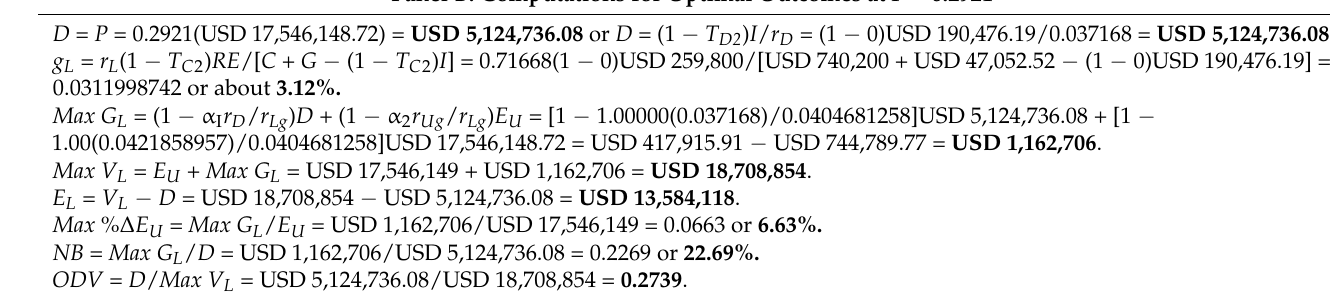
Panel B. Computations for Optimal Outcomes at P =